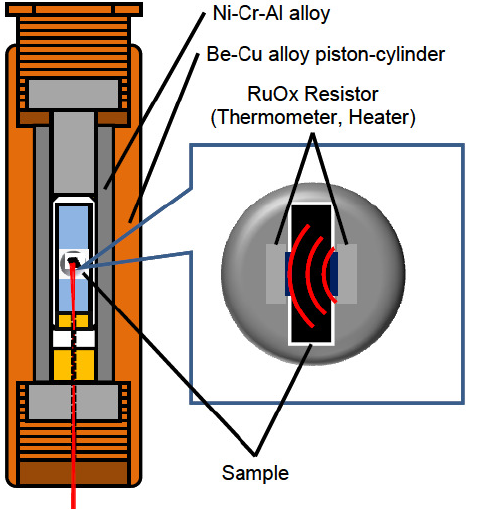
Figure 13. Schematic view of high pressure ac calorimeter for single crystal samples with 1–3 mg. The small ruthenium oxide chip type resistances utilized as a heater and a thermometer are attached on single crystal